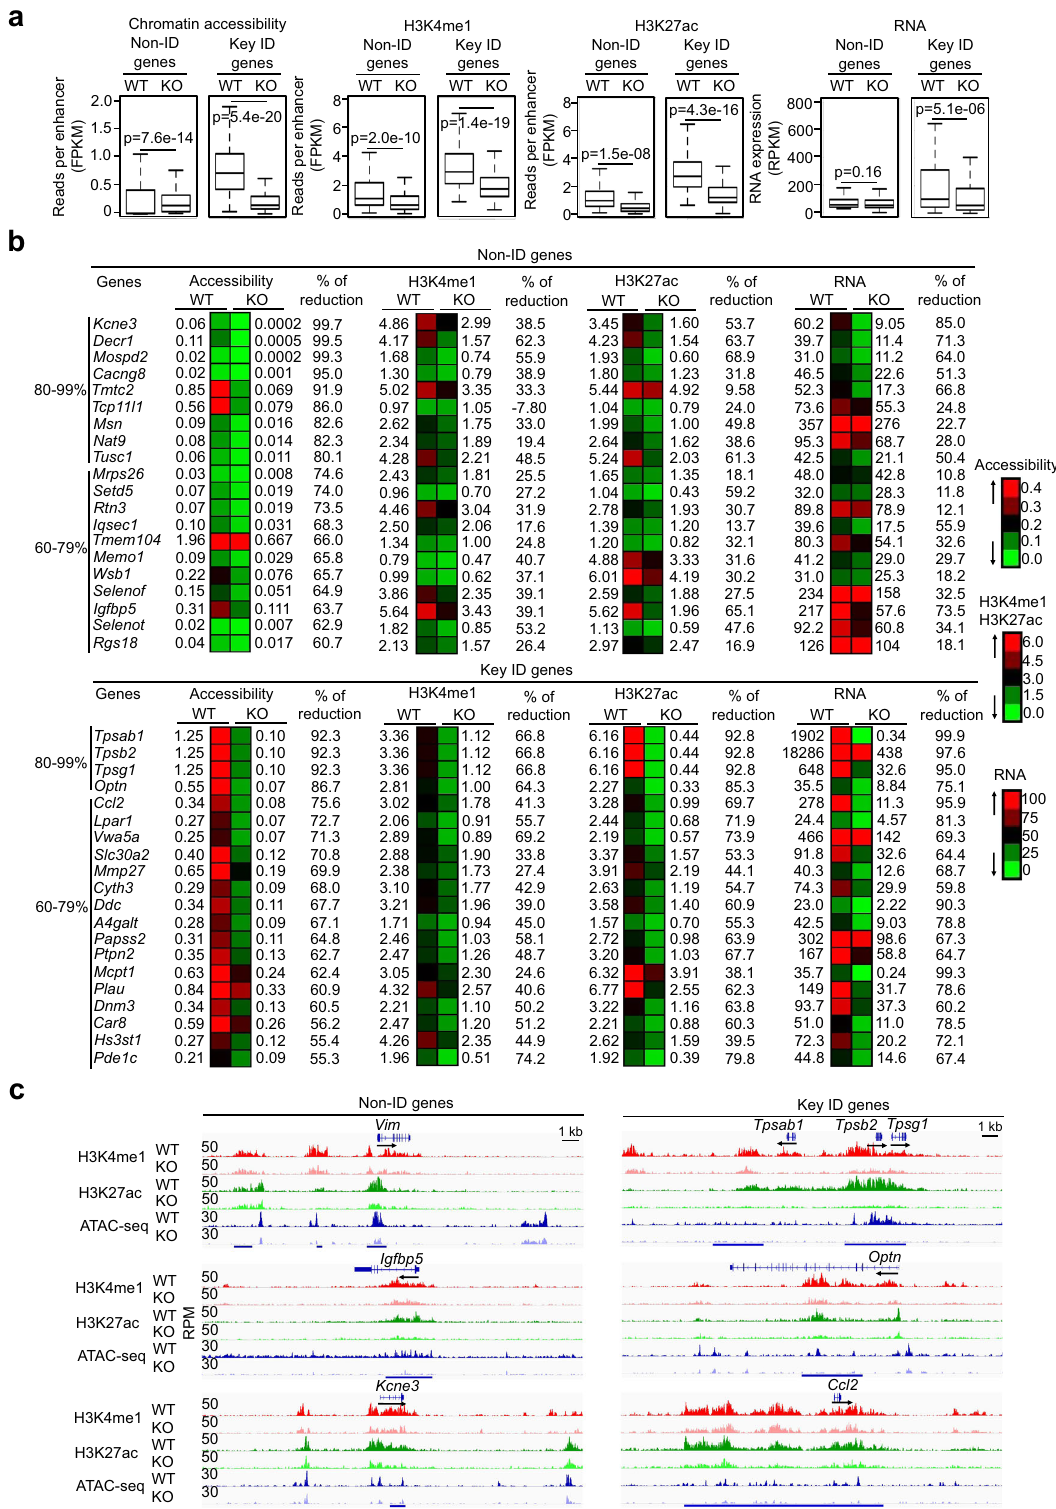
Fig. 3 GATA2 promotes chromatin accessibility and H3K4me1 and H3K27ac modi fi cations of histones associated with the MC genes. a Calculated average reads at enhancers for the key ID genes and the non-ID genes in wild-type MCs (WT) and Gata2 − / − MCs (KO). Middle line inside each box represents the median, upper and lower bounds of the box represent the third and fi rst quartiles, respectively. Whiskers represent 1.5 times of the interquartile range. P -values were calculated by a two-tailed student ’ s t test without adjustments. b Heatmap presentation of reads at the enhancers (FPKM) and RNA reads (RPKM). c Representative tracks. Data a – c represent two biological samples. The IGV tracks are generated from one biological sample, representing two biological replicates with similar patterns.